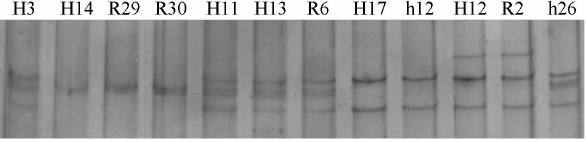
Figure 2 - Migration pattern of F4-R3b hsp70 fragment (359 bp) in acrylamide gel for some DNA chicken samples. H - Hubbard, R - PP1 na/na and h - PP1 Na/na.